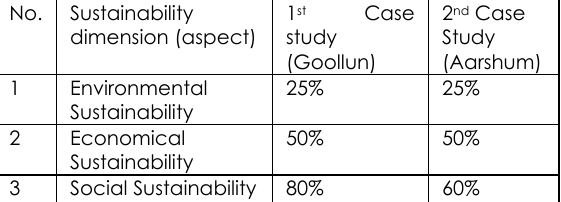
Table 6. The percentage of sustainability in the case study houses as per prepared factors in the checklist. (By